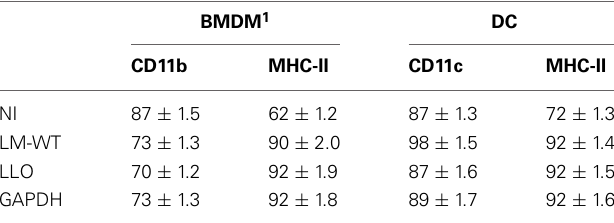
Table 1 | Surface markers of different BMDM and DC vaccine